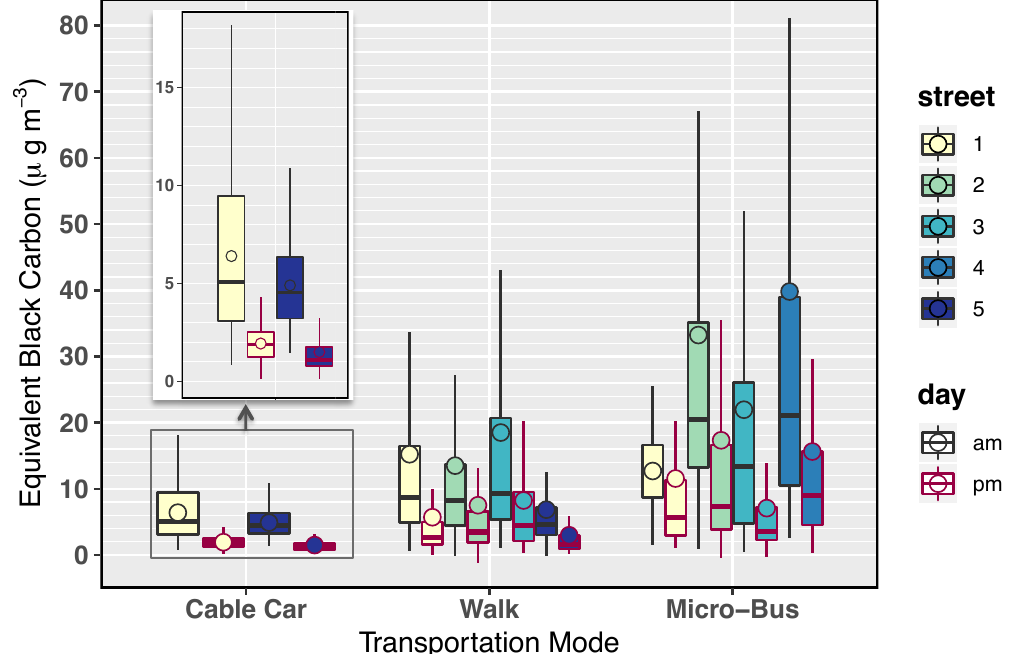
Figure 2. Equivalent black carbon exposure concentrations at STP conditions in di ff erent TMEs by travel time in each measurement routes. The top and bottom of the box-plot, respectively, correspond to the 25–75th percentiles, the horizontal bar shows the median, and mean values are represented by